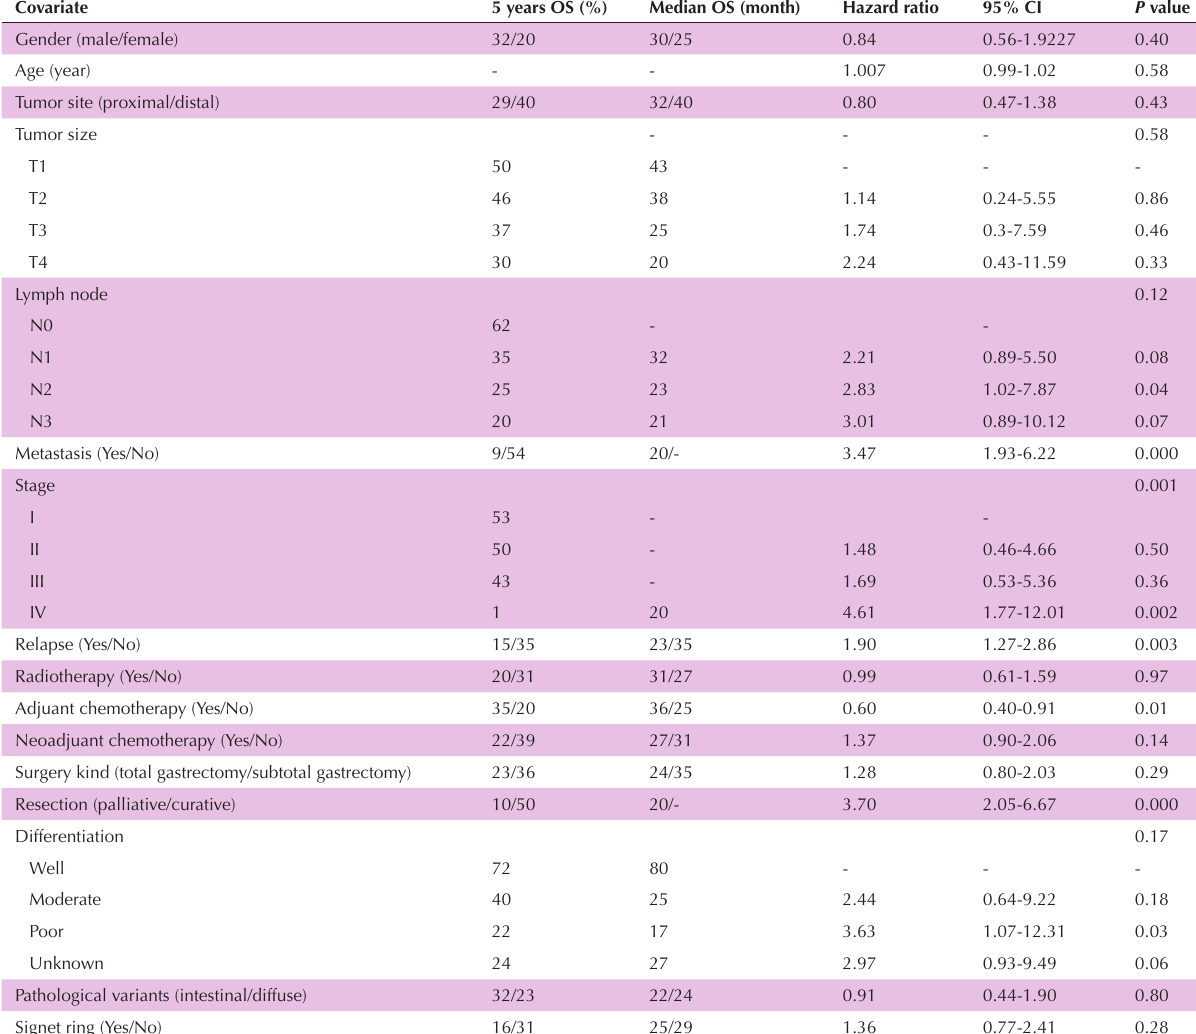
Table 2. Estimation of the coefficient of Cox proportional hazard model and hazard ratio for gastric cancer patients